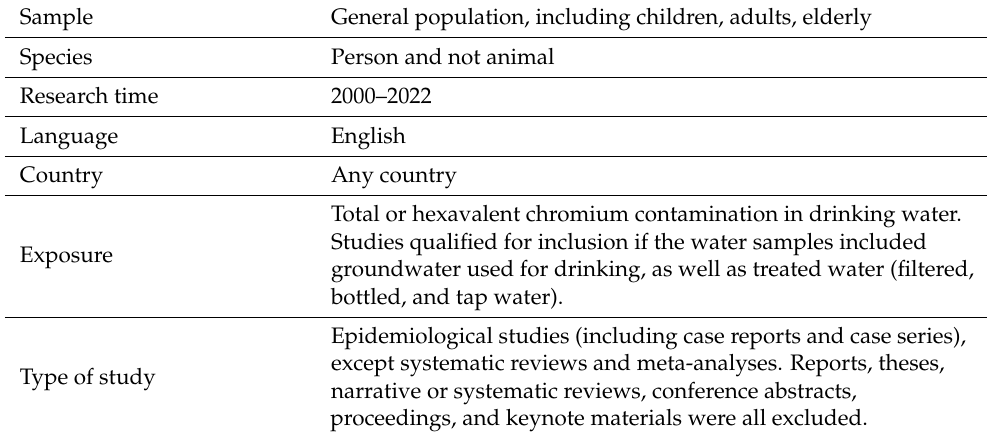
Table 3. Inclusion and exclusion criteria for the selection of relevant studies with the research